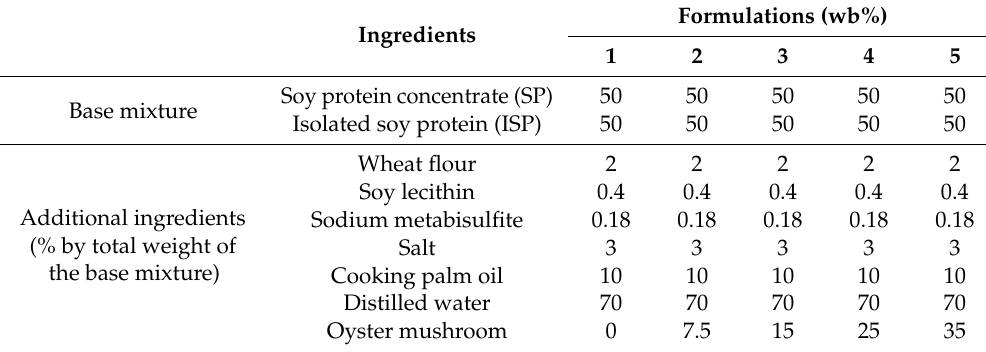
Table 1. Ingredient formulations at a di ff erent percentage of oyster mushroom